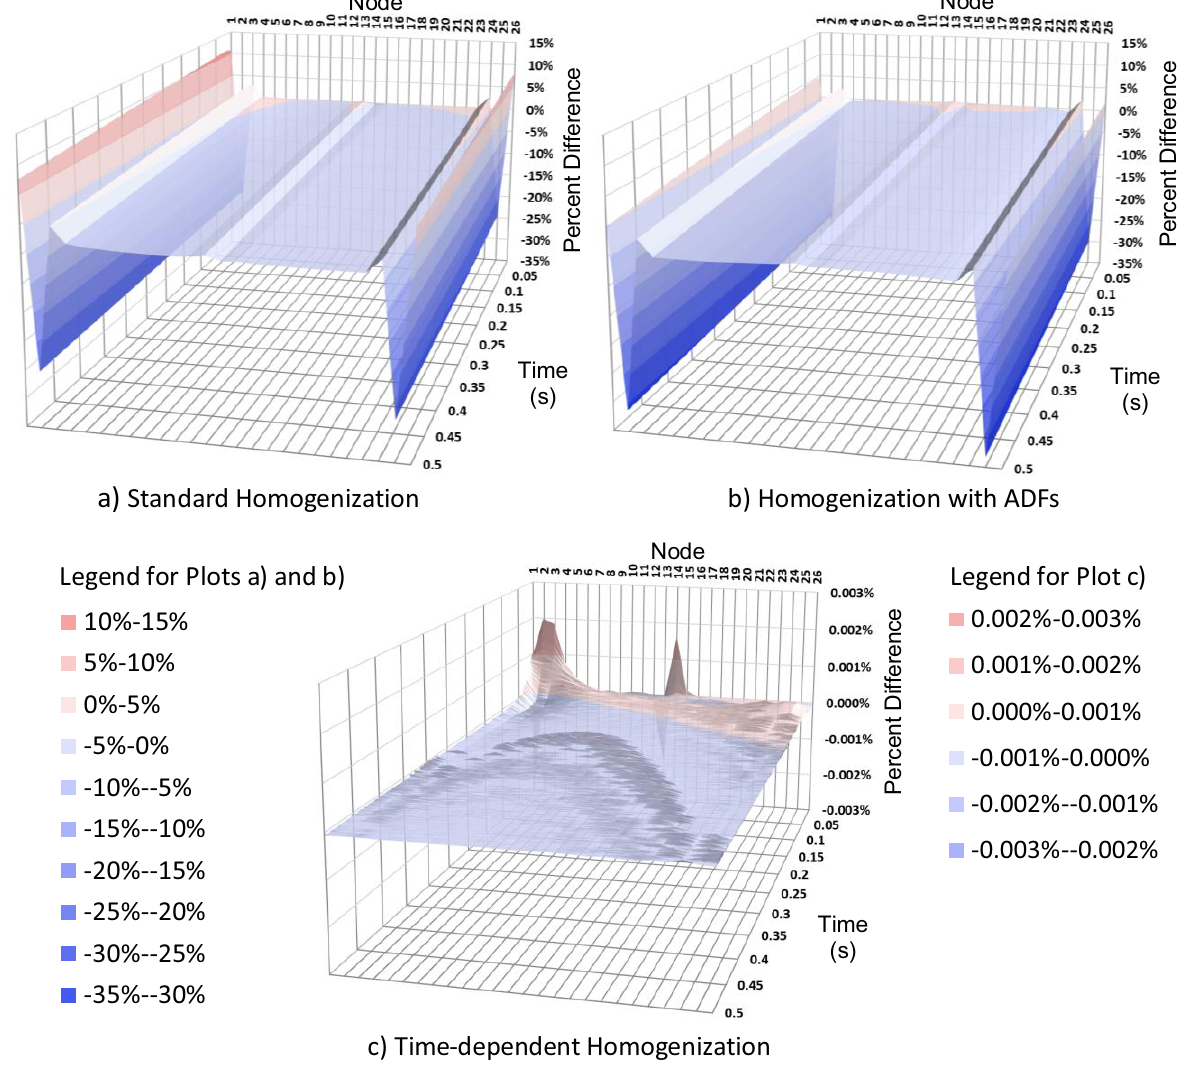
Figure 10. Percent Differences between the three Homogenization Techniques and the